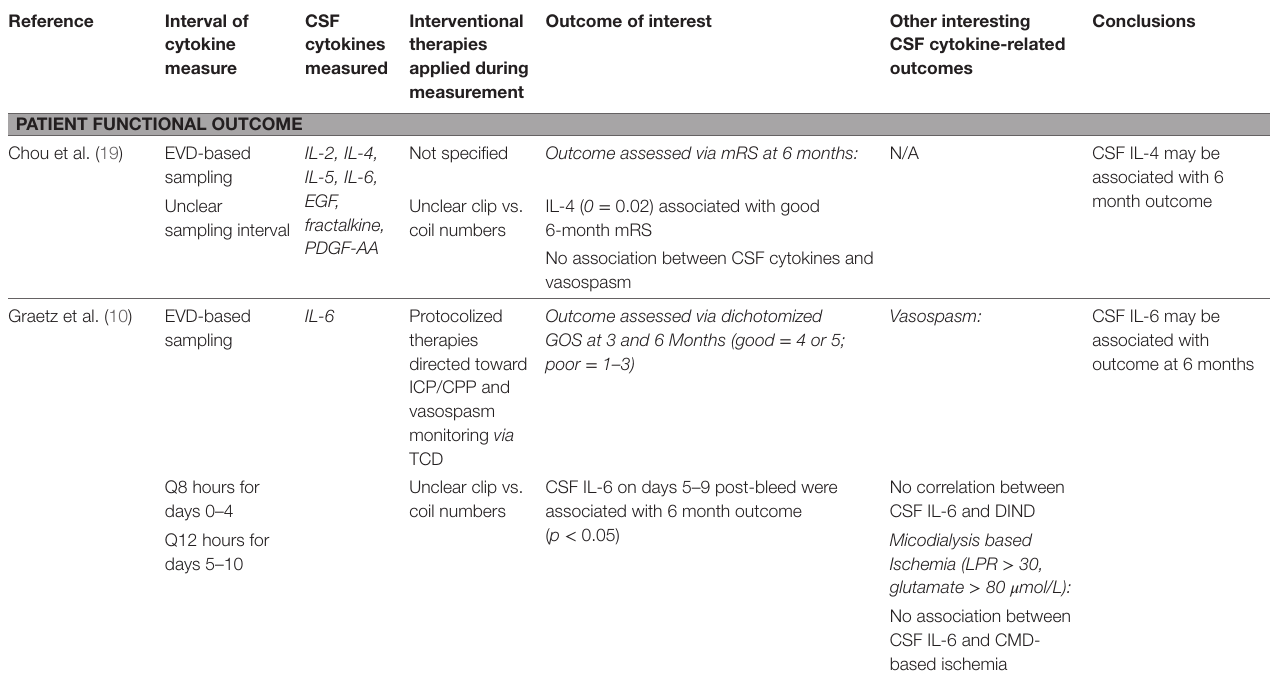
TABLe 4 | CSF cytokine measures and